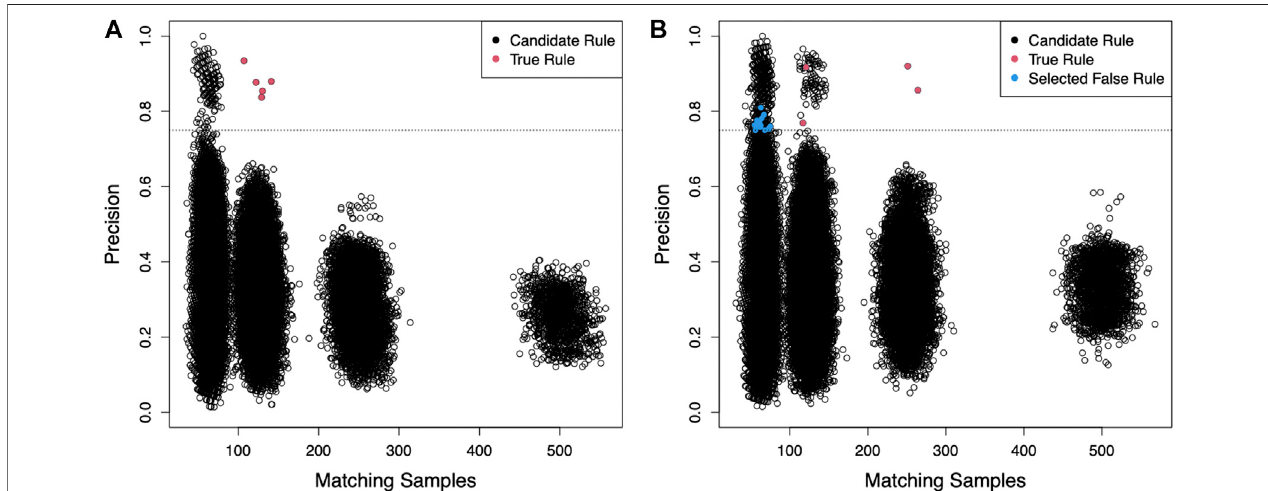
FIGURE2| Forboth scenarios 2,000samplesweregeneratedwith100randomlygeneratedbinaryfeatures. (A) Thegenerality ofsub-rules(numberofpoints that exactly satisfy the rule criteria) is plotted against their precision for the IDEALIZED scenario (Five rules that cause the phenotype and no noise). Each point represents a unique sub-rule. X -axis is the number of samples in the dataset that exactly match the pattern de fi ned by the rule. Y -axis is the fraction of matching samples with the observed phenotype (i.e., precision of the rule). Each cluster of points corresponds to decreasing rule complexity from 5 variables per rule to 2 on the right-most cluster.Theseclustersappearbecausethevaluesofeachvariableareproducedbyanidenticalbinomialdistribution.Thedashedlineistheprecisionthresholdwechose inordertoexcludelowqualityrules.Onlycandidateruleswithprecisionabovethisthreshold wereconsideredforthecuratealgorithm.Redpointsarethecausativesub- rules we de fi ned. BowSaw correctly identi fi ed all fi ve red points in this scenario. (B) Candidate sub-rules generated for the more challenging INTERMEDIATE scenario. We de fi ned 5 causative rules of varying lengths in this scenario and allowed 2% of samples without a causative rule to be assigned the label. BowSaw completely recovered 4 of the causative rules (red points). The longest rule which involved 5 variables was not fully recovered by any candidate rule. Rules that were selected by the Curate algorithm because of their contribution to additional coverage but that did not contain a complete true rule are indicated by blue